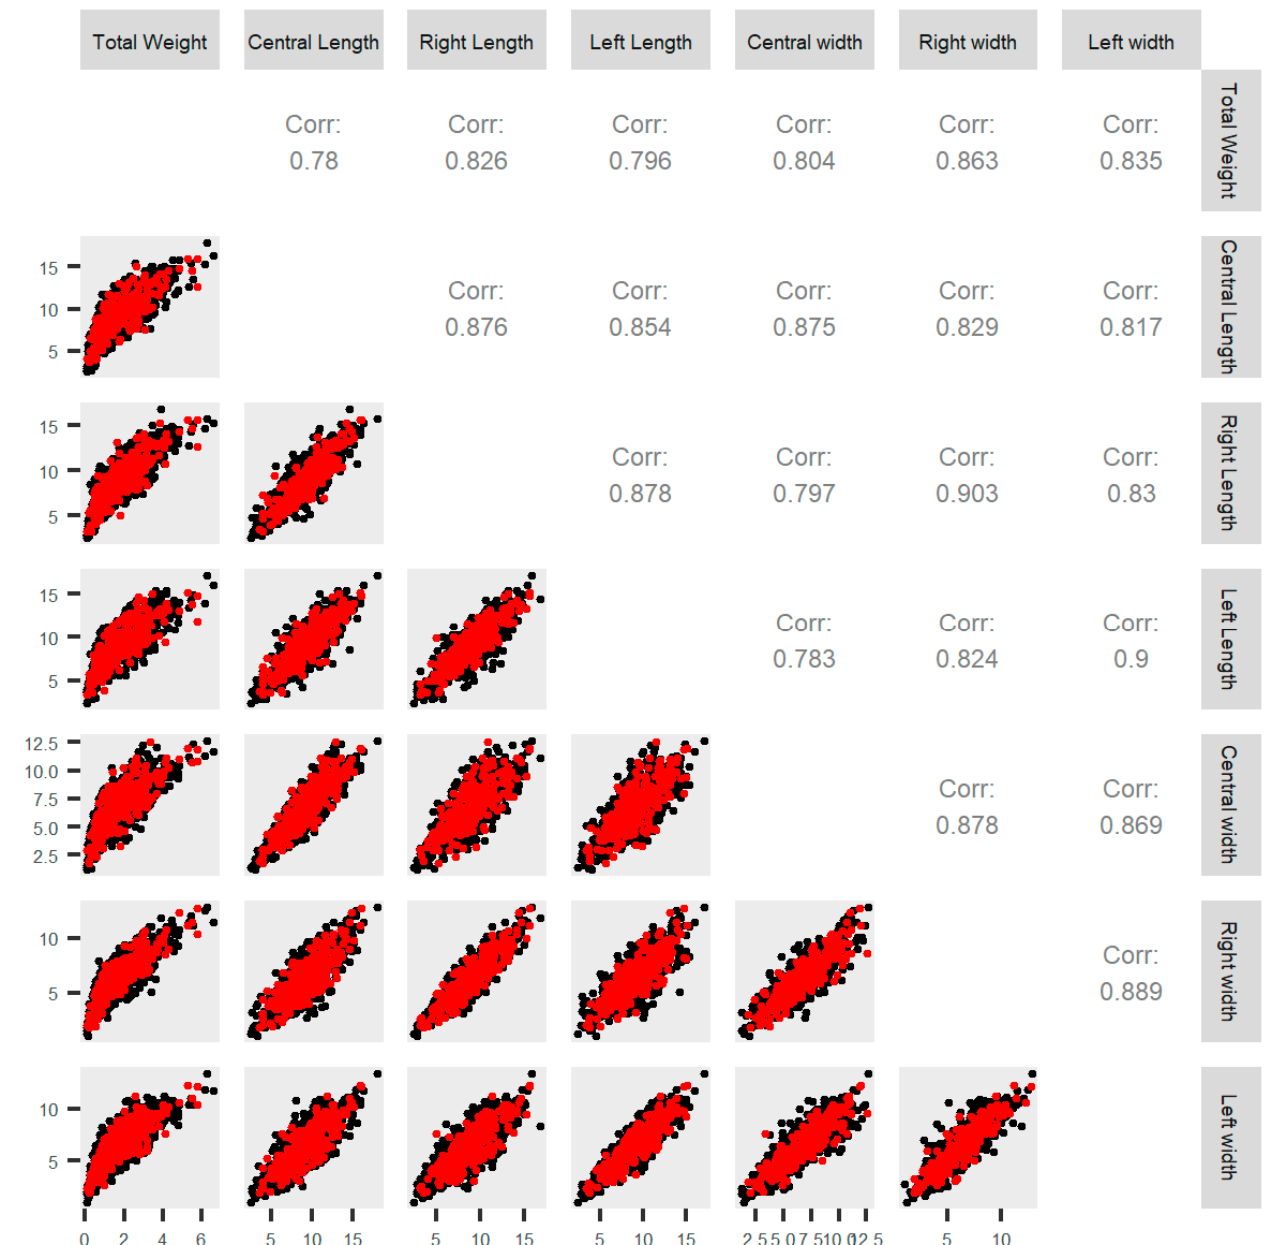
Figure 2. Scatter plots matrix between leaf total weight versus length and width of the central, right, and left leaflet of leaves in common bean. Validation observations in red, training observations in black. Corr: Pearson correlation coefficients.